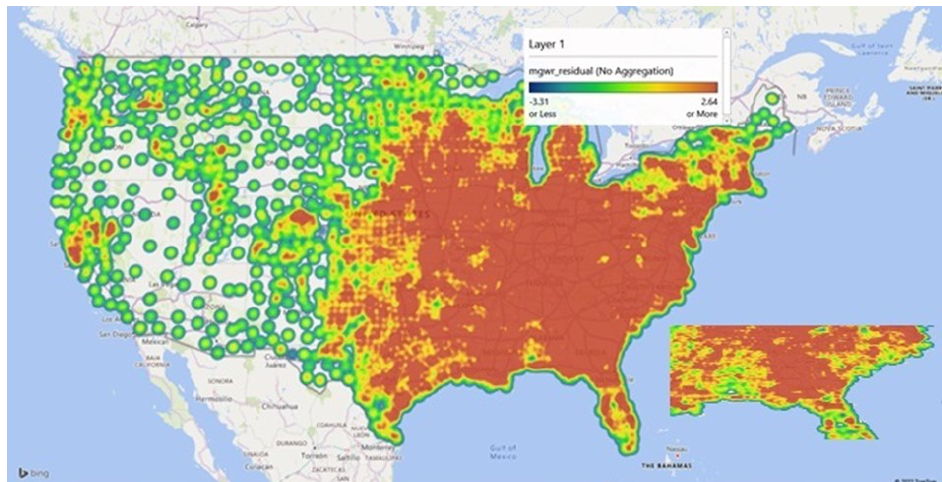
Figure 12. MGWR parameter estimate surfaces for the residuals which tend to show local patterns of spatial heterogeneity. Red areas are places where the model strongly predicts the actual value. Green tracts are not statistically different from zero while red tracts are statistically different than zero. Note: The Southern part of Georgia has been included in the bottom corner of the map to show that the red areas have also some intervening green areas (no